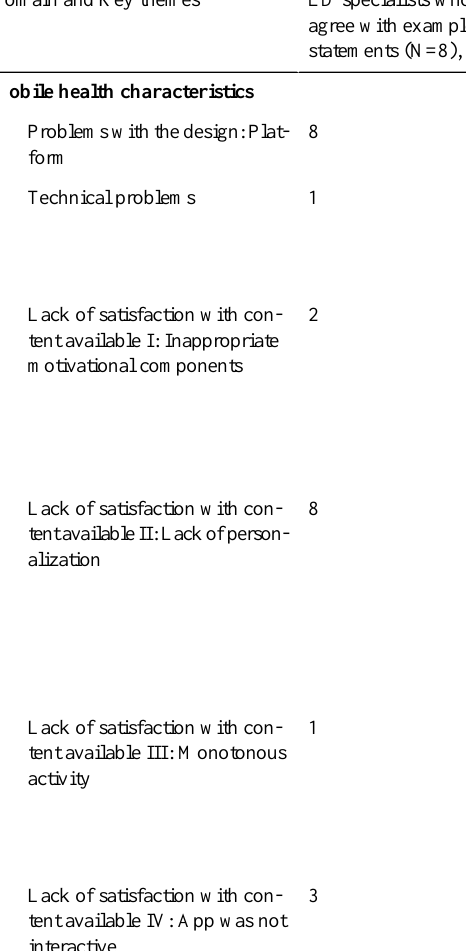
Examples of ED specialists´ statementsED specialists